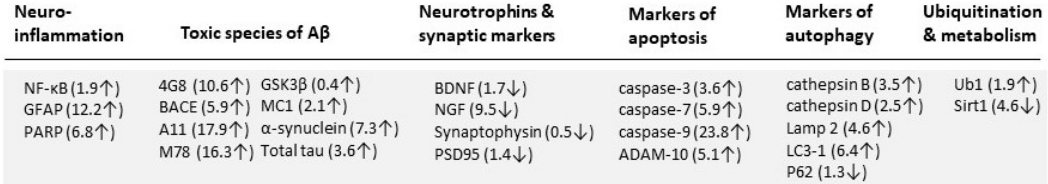
Figure 2 . The effects of Resv and exercise training (ET) markers of neuroinflammation. Treating 3xTg- AD mice with Resv or Resv with ET decreases the expression of key inflammatory markers.